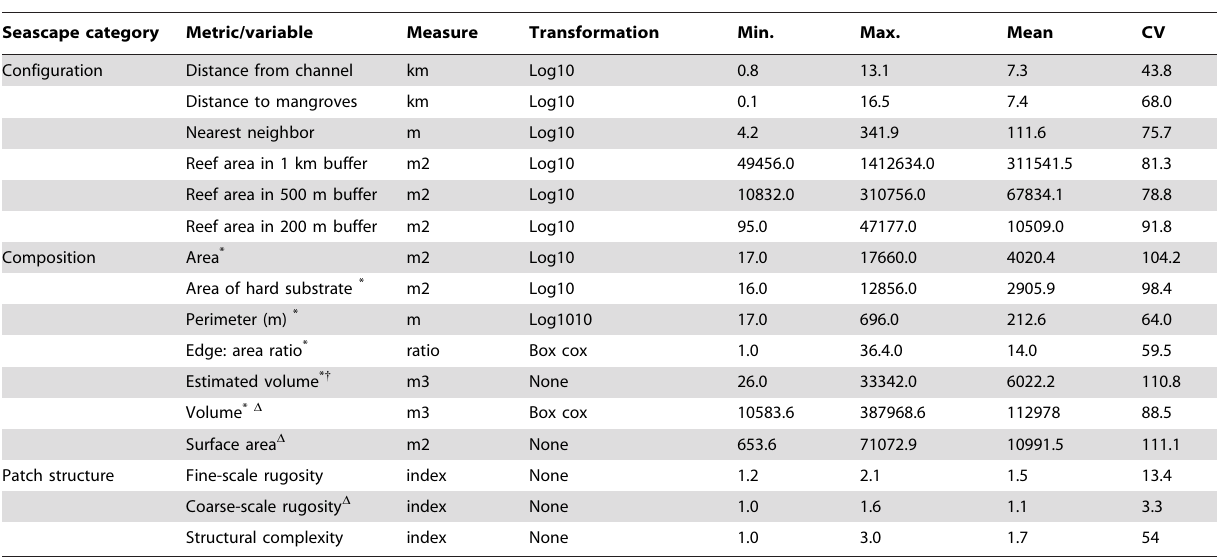
Table 1. Summary statistics for seascape metrics and patch structure variables.